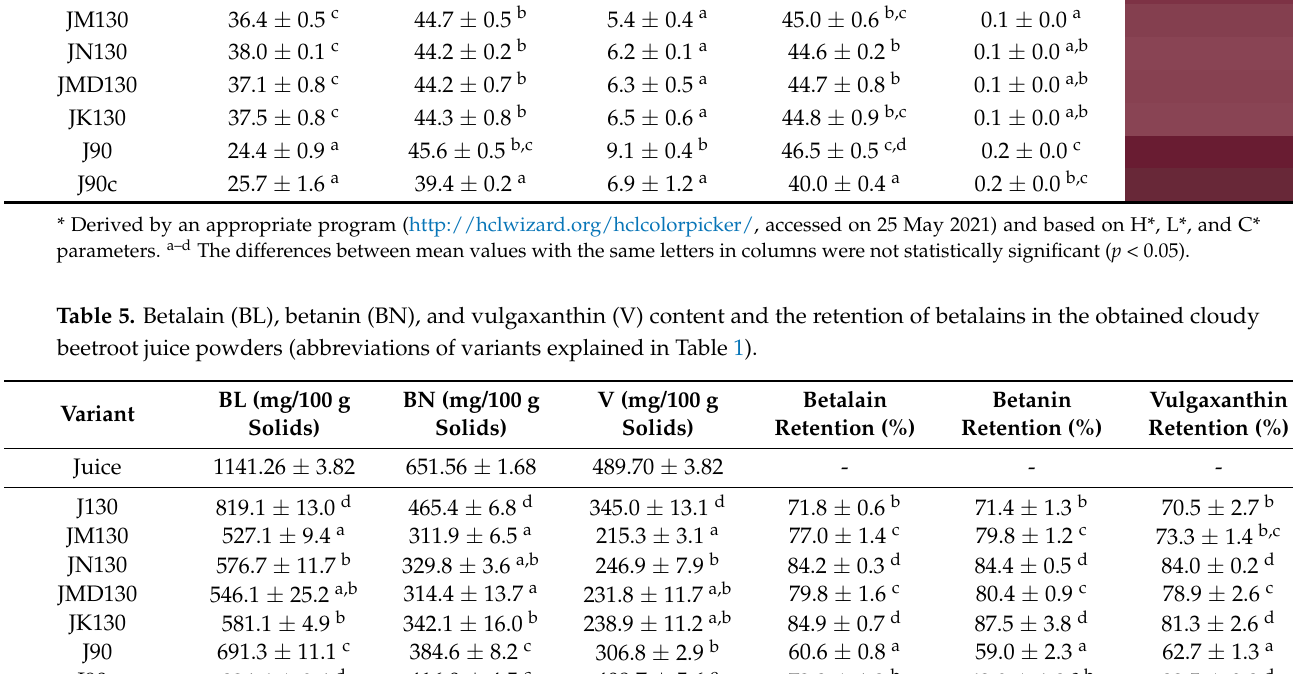
Table 4. Color parameters of cloudy beetroot juice powders (abbreviations of variants explained in Table 1). Variant